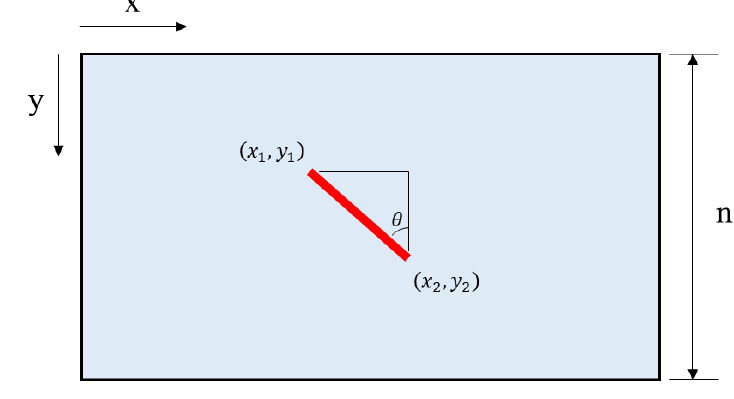
Figure 4. Image parameters and the RSE.